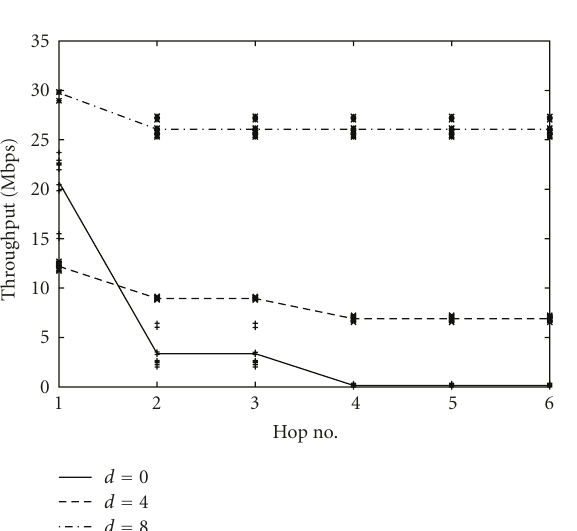
Figure 21: Performance of multihop, 802.11a, 17 dBm.